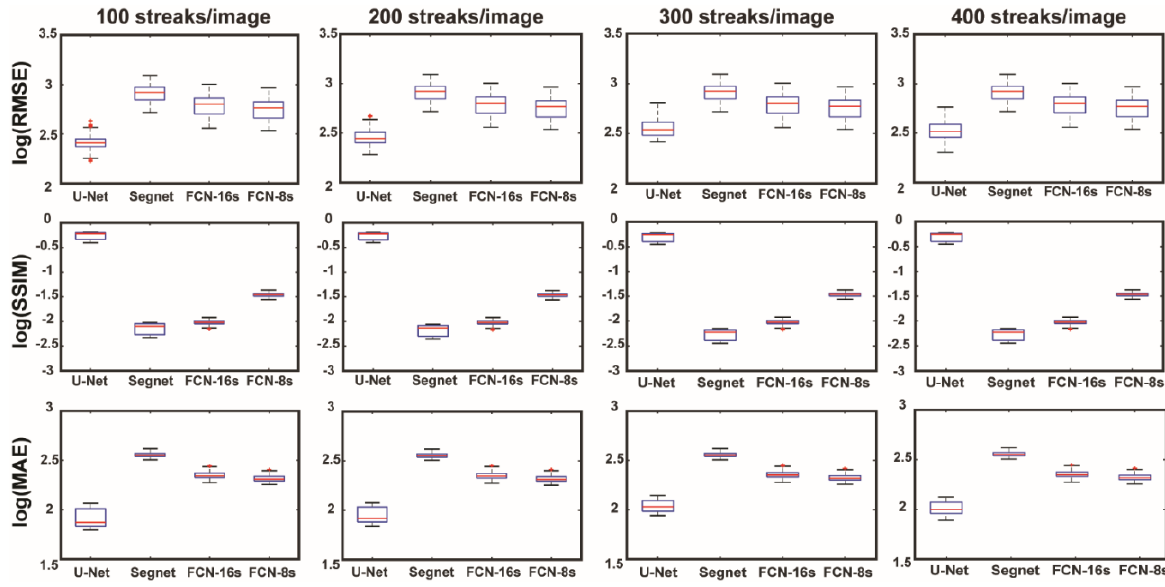
Figure 3. Performance metric comparison between trained CNNs’ log ‐ scaled RMSE (top) and SSIM (middle) and MAE (bottom) for each noise level (streaks per image) using the test set. The smaller the RMSE and MAE and the larger the SSIM, the better reconstruction we have. Further comparison with classical approaches can be found in Supplementary Figure